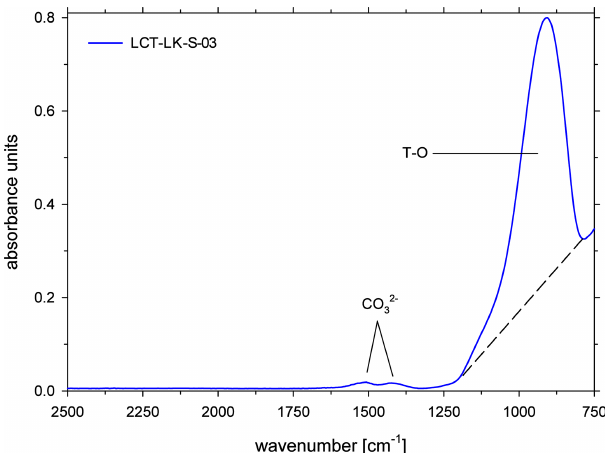
Figure 4. ATR-FTIR spectra of CO 2 -rich, anhydrous glass; the dashed lines mark the TT baseline that was applied to integrate the peak area of the T –O band for